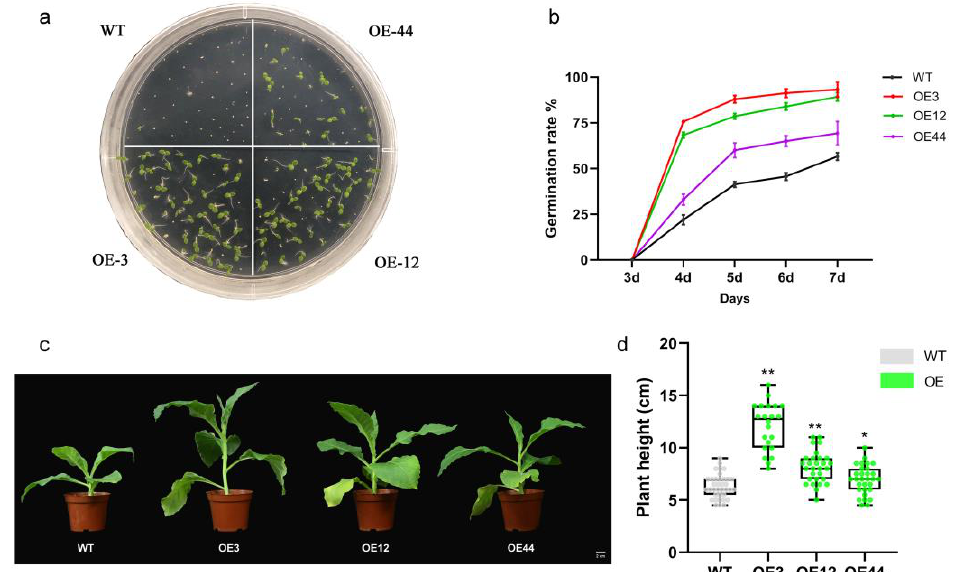
Figure 2. Growth phenotypes of the NpPP2-B10 -OE lines and WT plants. ( a ) Germination of seeds from each line after one week of incubation on MS medium. ( b ) Germination rate of each line on wet filter paper. ( c ) Growth phenotype of each line at two months of age. ( d ) Plant height of each line at two months of age. Asterisks denote significant differences (compared with the control group): * p < 0.05, ** p < 0.01, by Student’s t -test.